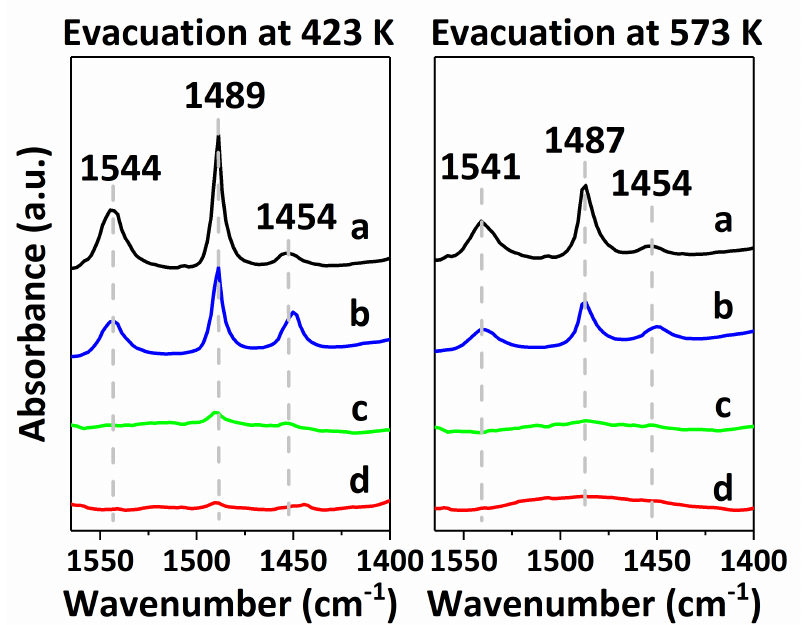
Figure 6. Pyridine FTIR spectra on (a) H-ZSM-5, (b) Fe/ZSM-5, (c) H-ZSM-5-ST and (d)